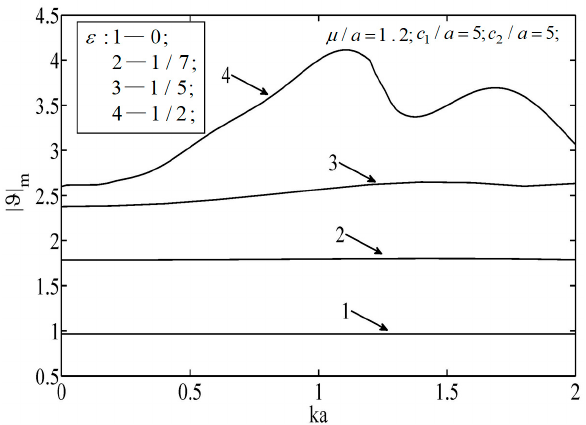
Figure 9. Temperature on the surfaces of the block.